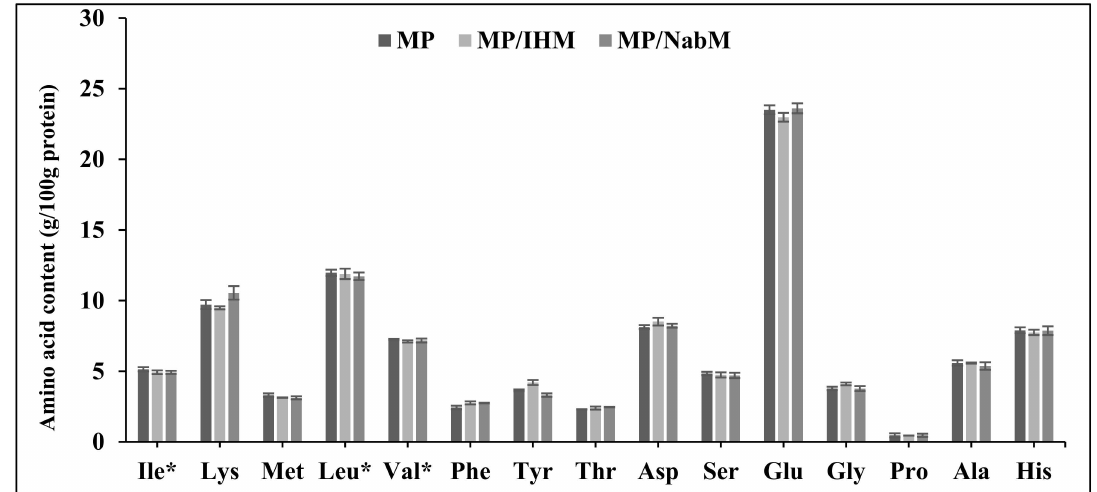
Figure 4. Amino acid profile of MP, MP/IHM, and MP/NabM. MP: milk proteins concentrate, MP/IHM: milk pro- teins/Isabgol husk mucilage complex and MP/NabM: milk proteins/Nabeq mucilage complex.* essential amino